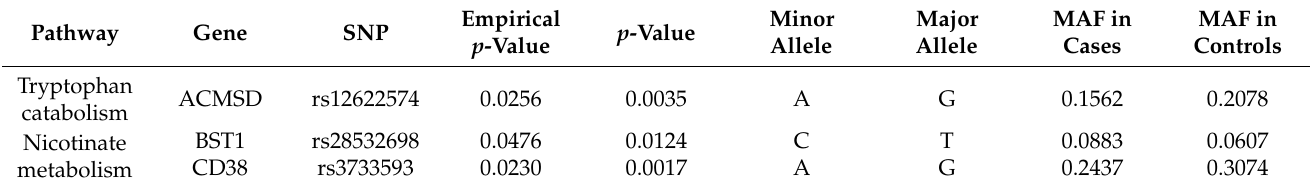
Table 3. Information of significant genes and SNPs in tryptophan catabolism and nicotinate